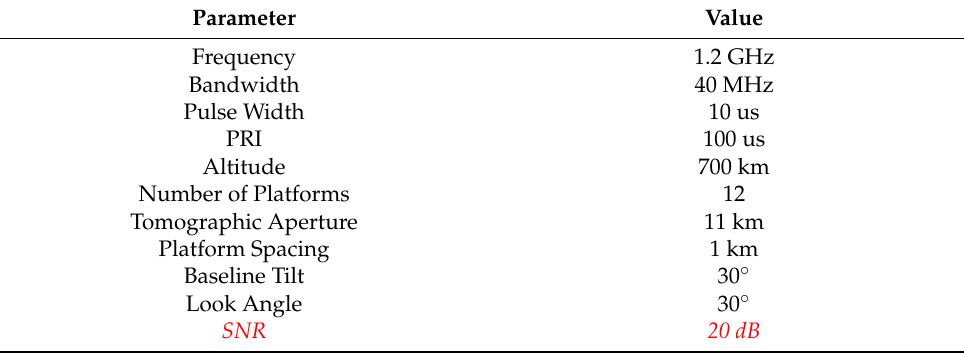
Table 5. Parameters used for Example